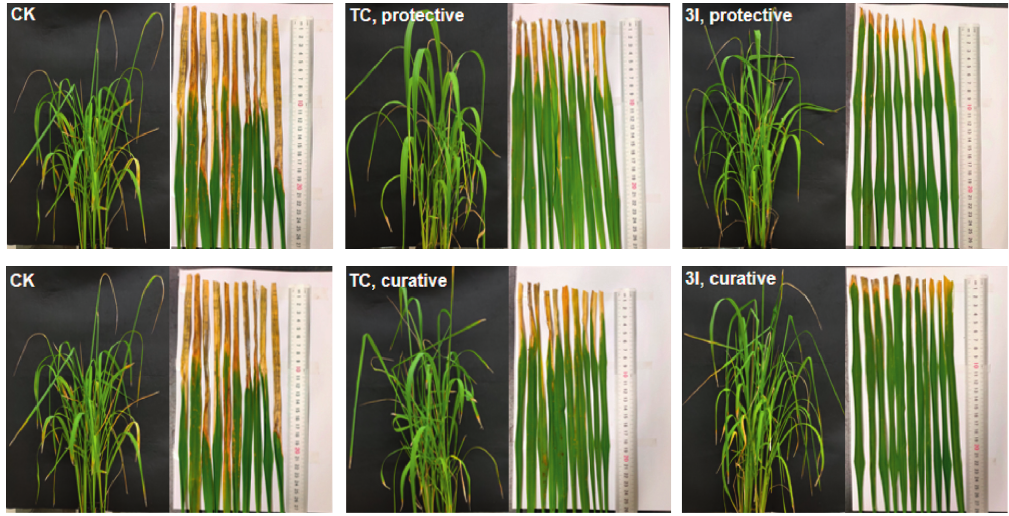
Figure 4: Protective and curative effects of compound 3l against rice bacterial blight at 200 μ